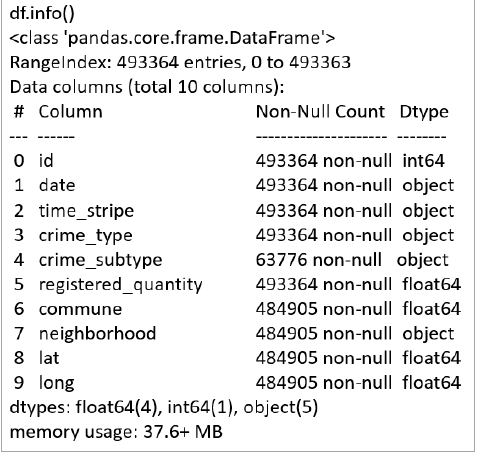
Figure A1. Initial data frame. Source: Own elaboration. Table A1. Exploration of each column.